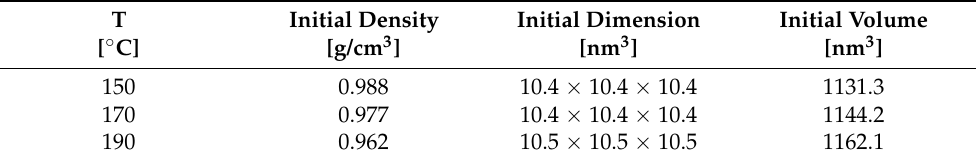
Table 2. The density of the initial molecular mixture in a simulation cell equilibrated at 150 ◦ C, 170 ◦ C, and 190 ◦ C.